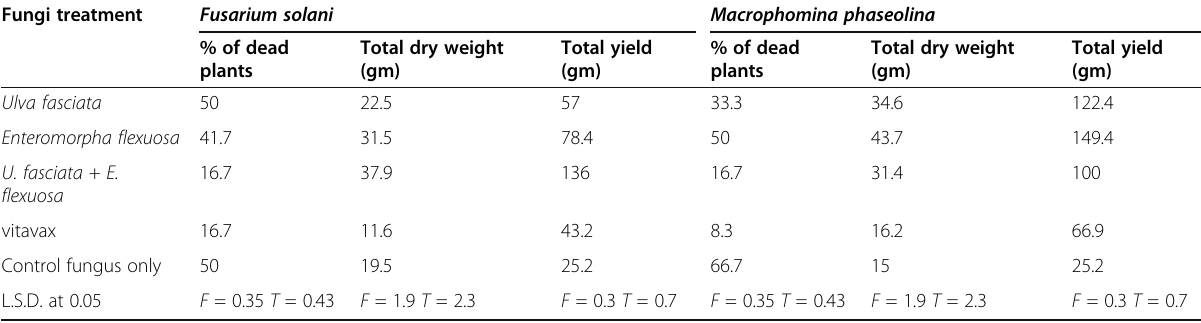
Table 3 Effect of green macroalgal powder treatments on the percentage of dead plants, total dry weight (gm) and total yield (gm) infested with the two pathogens compared with vitavax fungicide after 60 days of planting Fungi